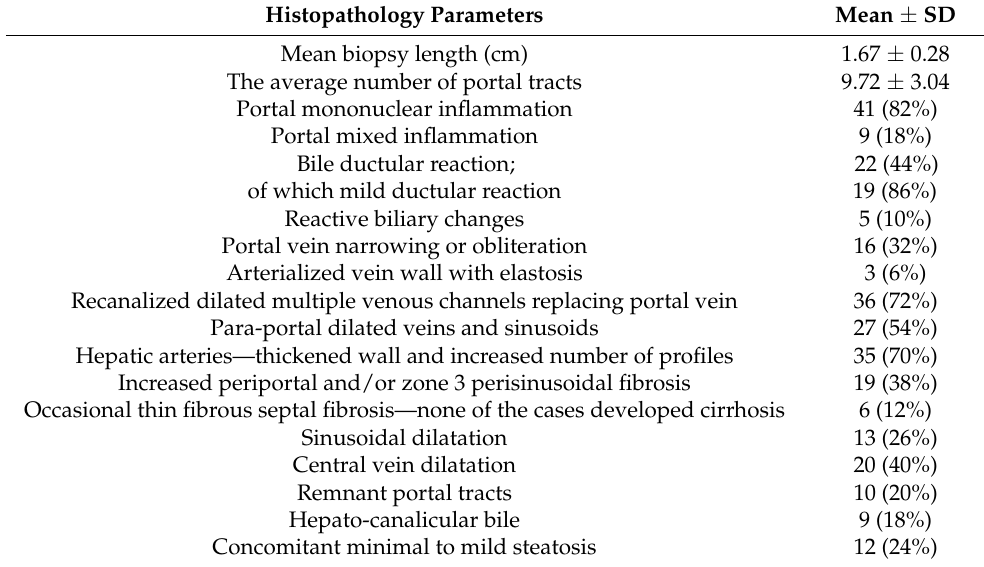
Table 3. Histopathological characteristics and their prevalence in portal biliopathy ( n = 50).